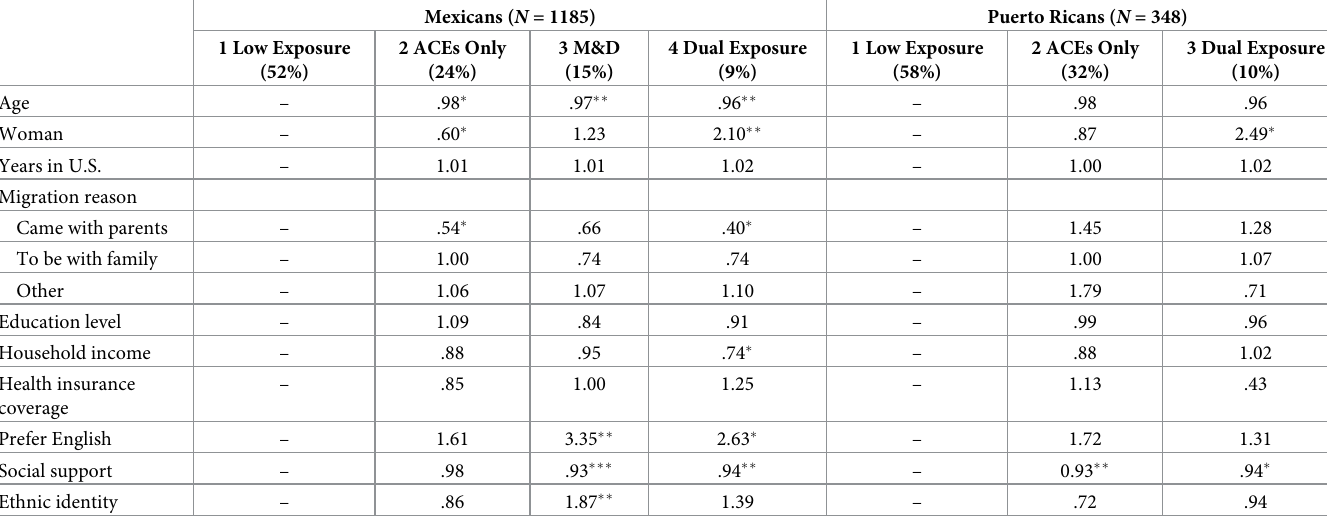
Table 6. Results from LPA with covariates analysis for Mexicans and Puerto Ricans: Odd